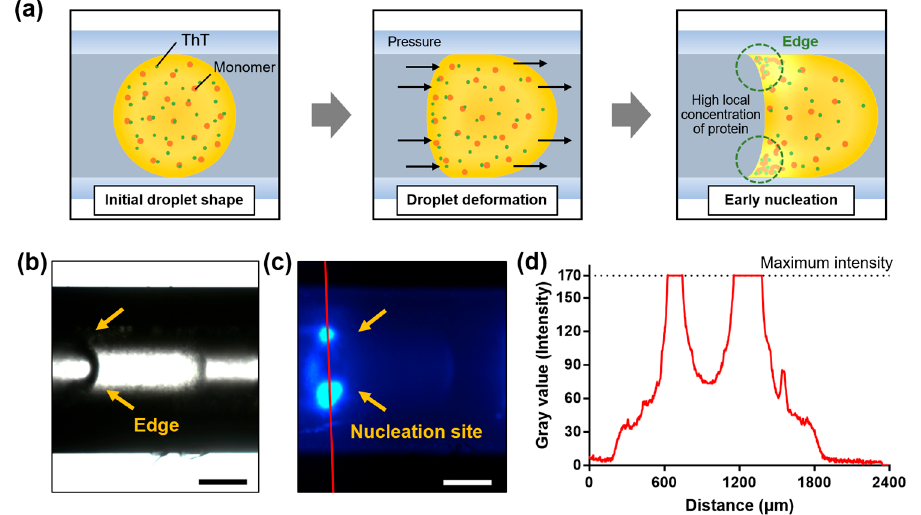
Figure 4. Rapid amyloid nucleation at vicinity of concave meniscus of droplets. ( a ) Schematic illustration showing droplet deformation into a bullet-shaped droplet due to asymmetric internal pressure. ( b ) Bright-field microscopy. ( c ) ThT fluorescence image of bullet-shaped droplet. ( d ) Profile of fluorescence intensity based on fluorescence image ( c ).